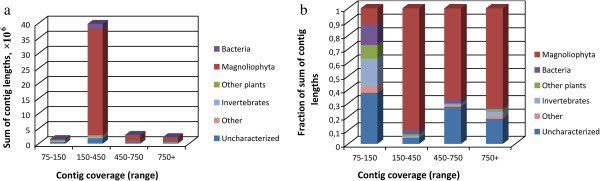
Total length of Genlisea aurea contigs, split into four bins according to the coverage. For each bin, the total lengths of contigs with the best BLAST hits in different groups of species are shown by color (A). Relative contributions of contigs with the best BLAST hits in different groups of species to the total lengths of contigs with different coverages (B).